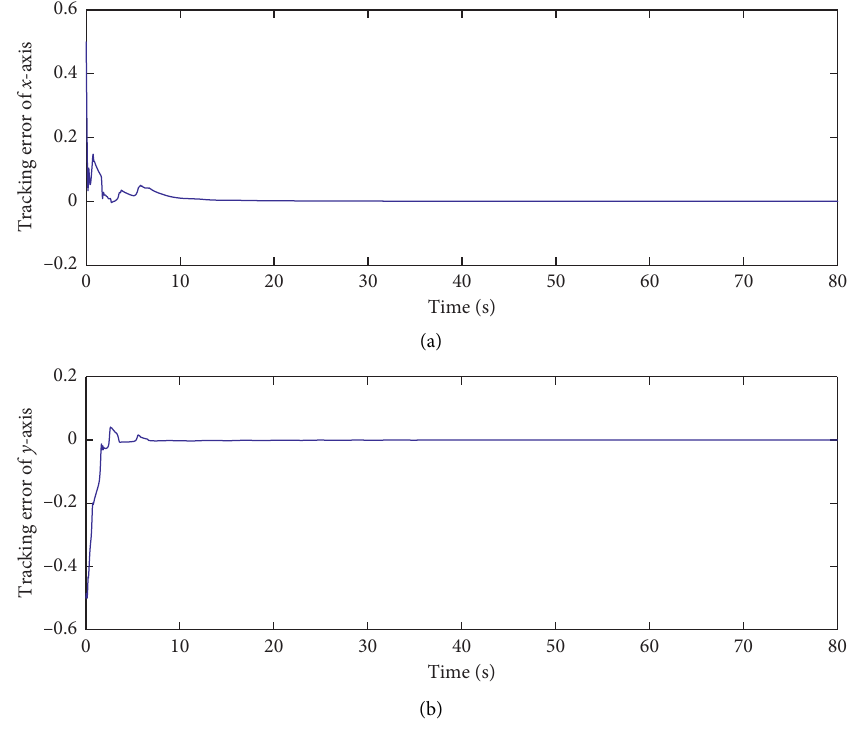
Figure 5: Tracking error using fractional sliding